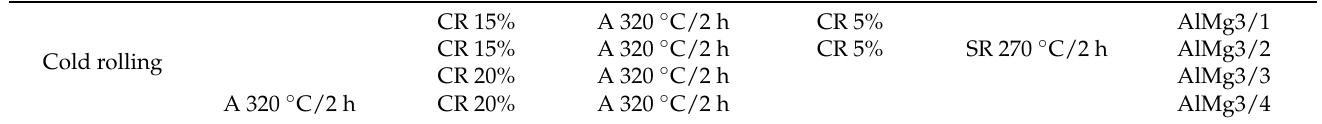
Table 2. The sequence of cold rolling, annealing and stress releasing